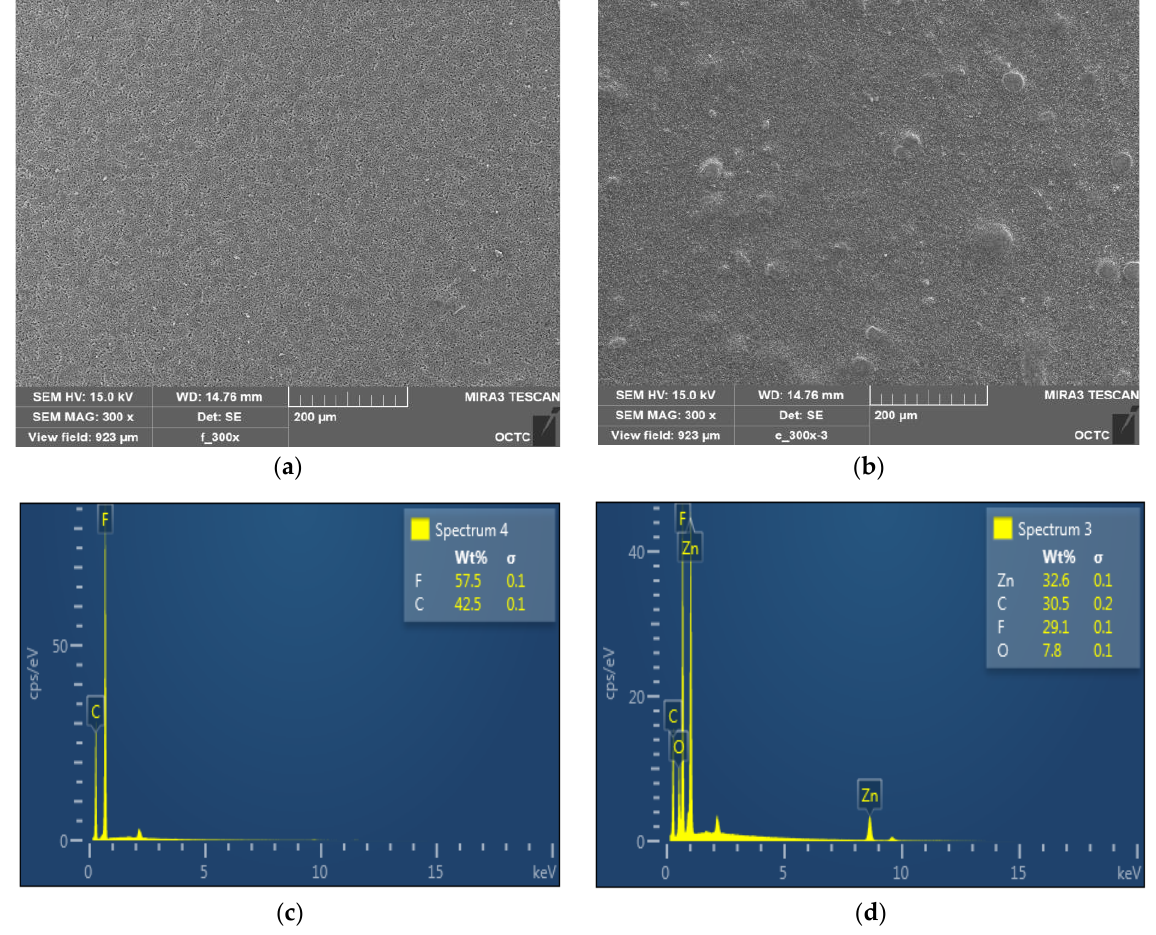
Figure 4. SEM images ( a ) PVDF, ( b ) PVDF/ZnO; corresponding EDS spectrum ( c ) PVDF, ( d ) PVDF/ZnO.